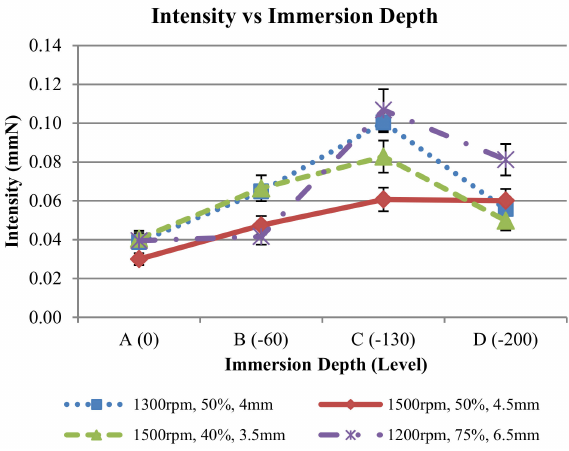
Figure 5. Intensity vs. immersion depth at di ff erent